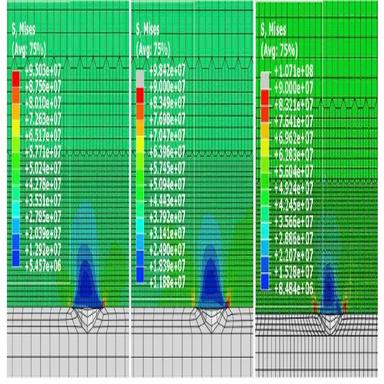
Steady-state stress distribution in PTFE composite sliding again steel surface with narrow & shallow dimples in (a) low coverage (0.4%), (b) medium coverage (1.6%) and c) high coverage (6.4%).